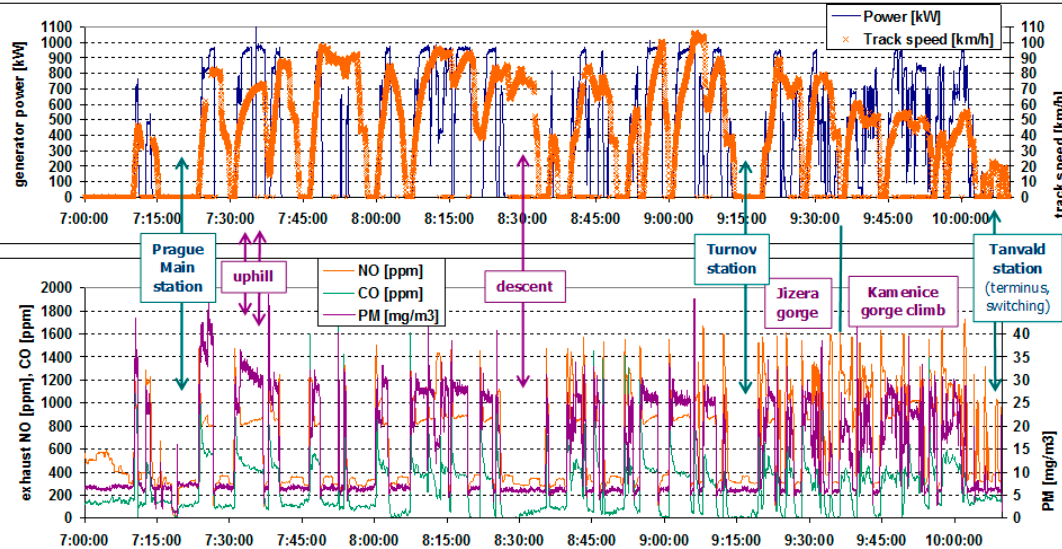
Figure 6. Measured values of running speed and generator power output (top); and concentrations of NO x , PM, and CO in the exhaust (bottom) of the ˇCKD 749 diesel-electric locomotive pulling a five-car, 297 t passenger train on the Praha–Tanvald line along a foothills route.